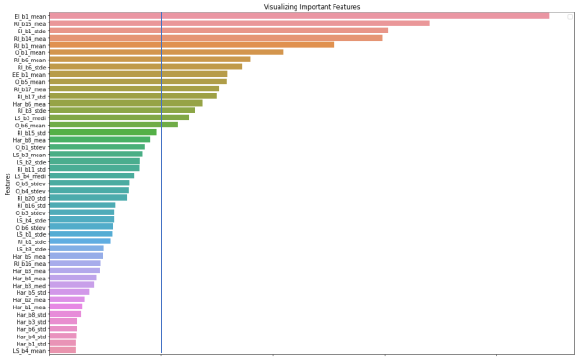
Figure 6. Importance analysis with Gini criterion for the object- based classification.